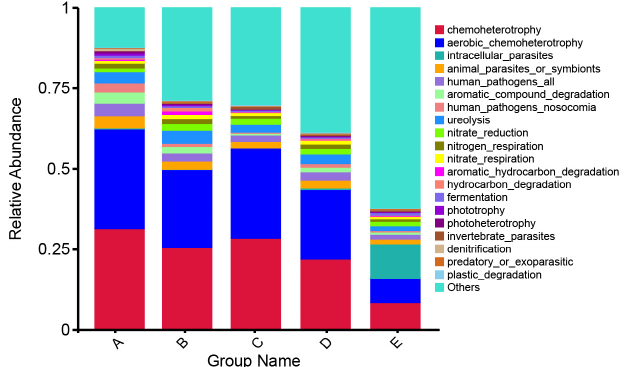
Figure 7. Metabolic community analysis in bacterial communities during plastic degradation of PPC mulch based on FAPROTAX. Degradation stage: A, in the stage of degradation adaptation, the community is enriched; B, in the early stage of degradation, the plastic begins to degrade; C, in the middle stage of degradation, the plastic begins to break; D, in the late stage of degradation, the plastic is completely fragmented; E, in the final stage of degradation, the plastic basically